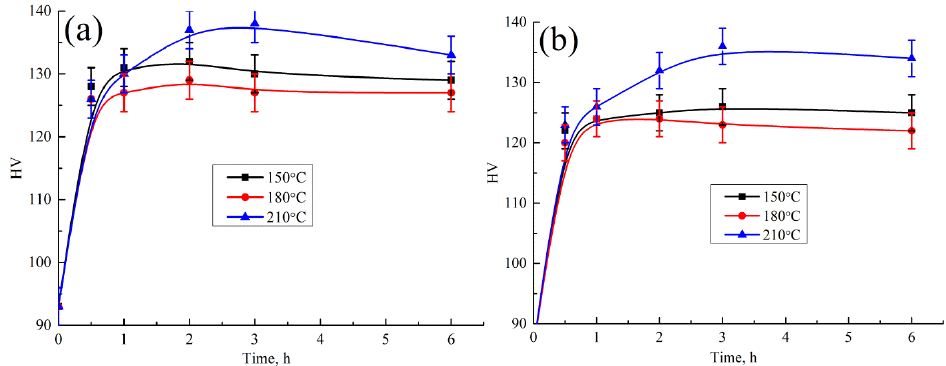
Figure 6. Aging curves of the ( a ) AlCuYbMg and ( b ) AlCuGdMg alloys. Table 4 and Figure 7 demonstrate the results of the tensile test and typical tensile curves at different temperatures of quenching and aging at 210 ◦ C for 3 h alloys. The UTS of the AlCuYbMg and AlCuGdMg alloys at room temperature are 338 and 299 MPa, respectively.